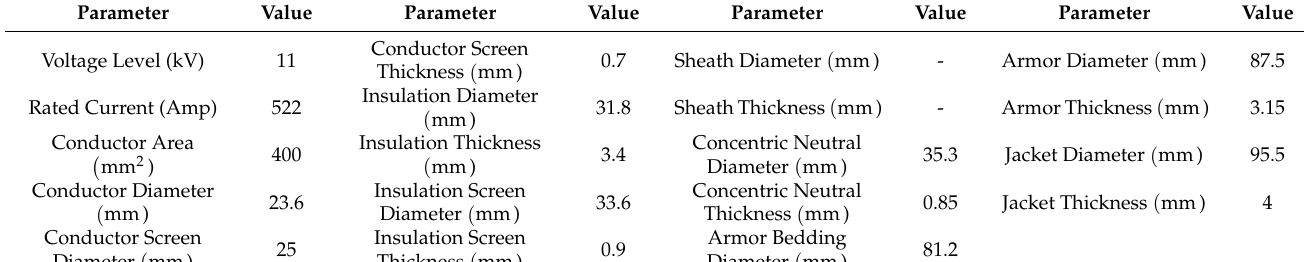
Table 1. Specification of the 400 mm 2 11 kV XLPE cable.